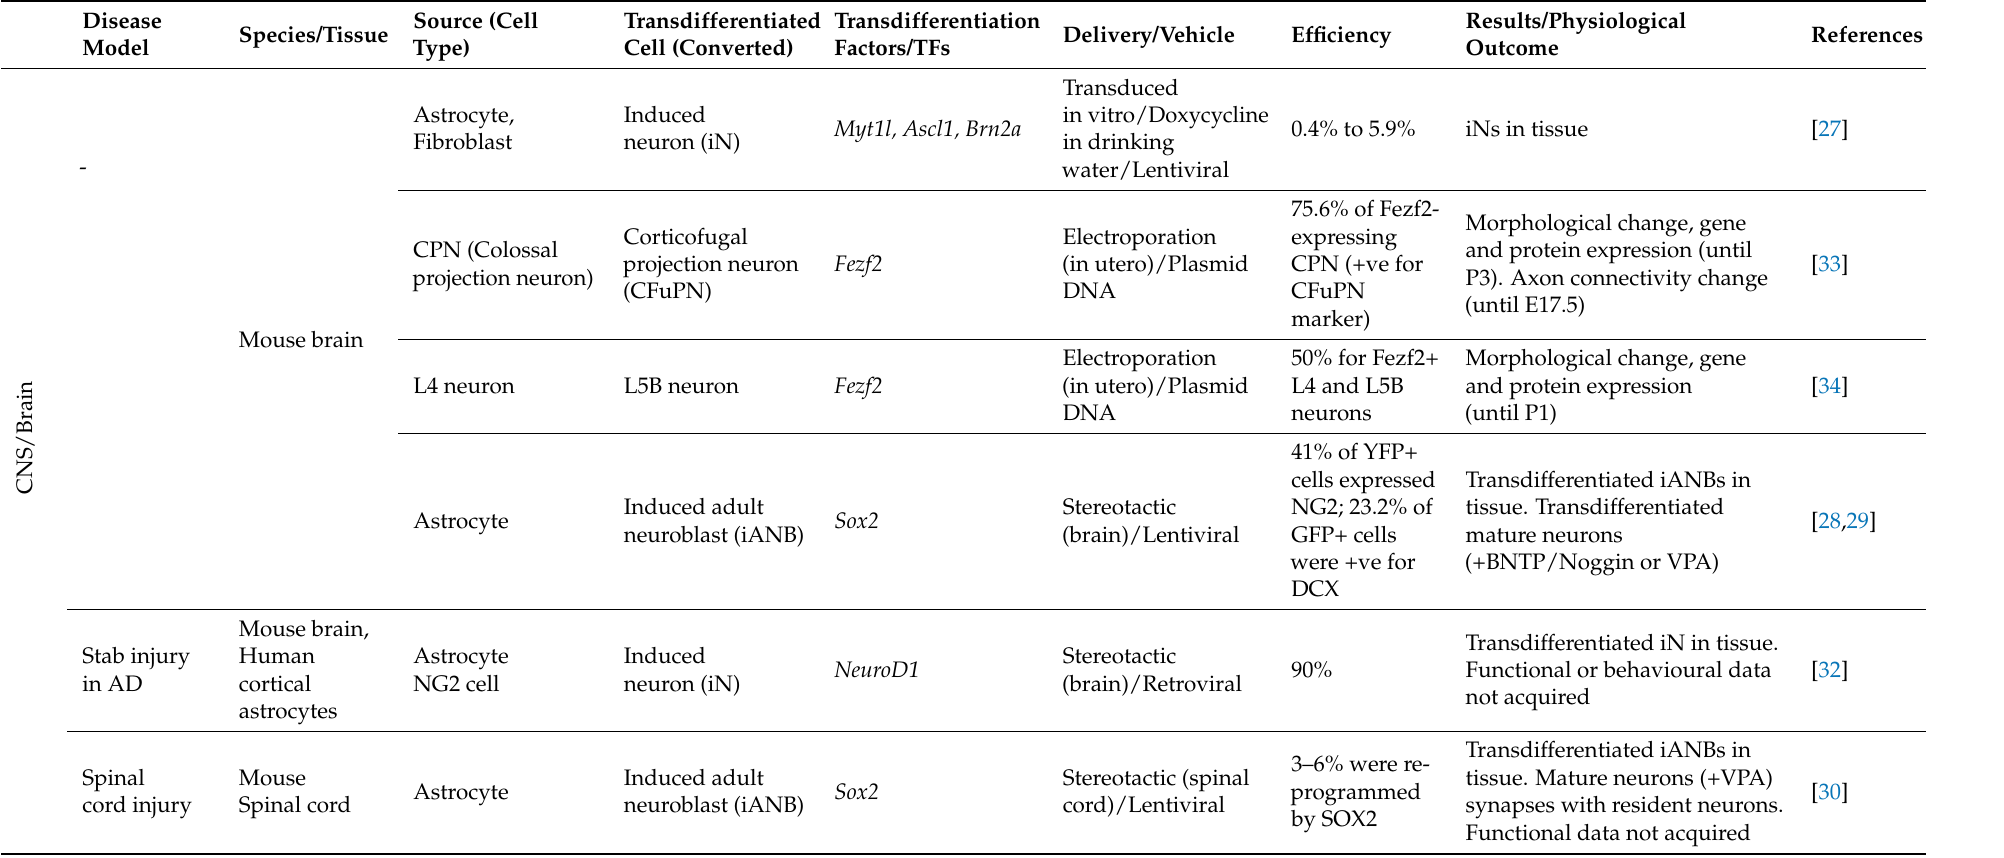
Table 1. Transcriptional factor(s)(TFs)-induced transdifferentiation, mechanism of action, and outcomes in the CNS/brain and cardiac model